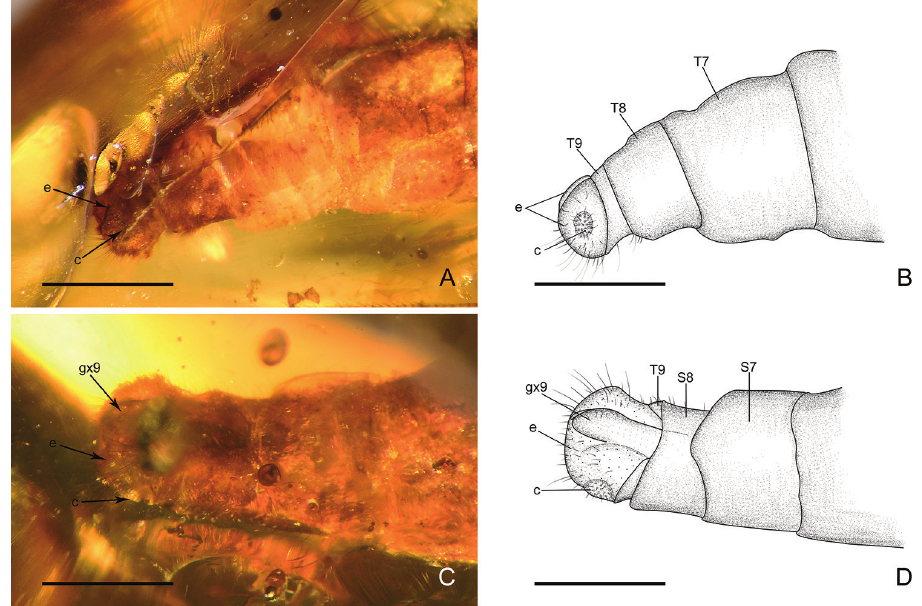
Figure 4. Genitalia of Parababinskaia makarkini sp. n., male. A Photograph of genitalia, lateral view B Drawing of genitalia, lateral view C Photograph of genitalia, ventral view D Drawing of genitalia, ventral view. Abbreviations: T: tergum; S: sternum; c: callus cercus; e: ectoproct; gx: gonocoxite. Scale bars: 1.0